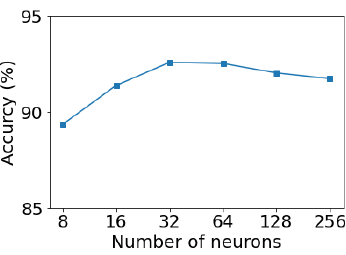
Figure 6. Effect of the number of neurons on convolutional neural network performance. Table 1. Convolutional neural network architecture for experiment